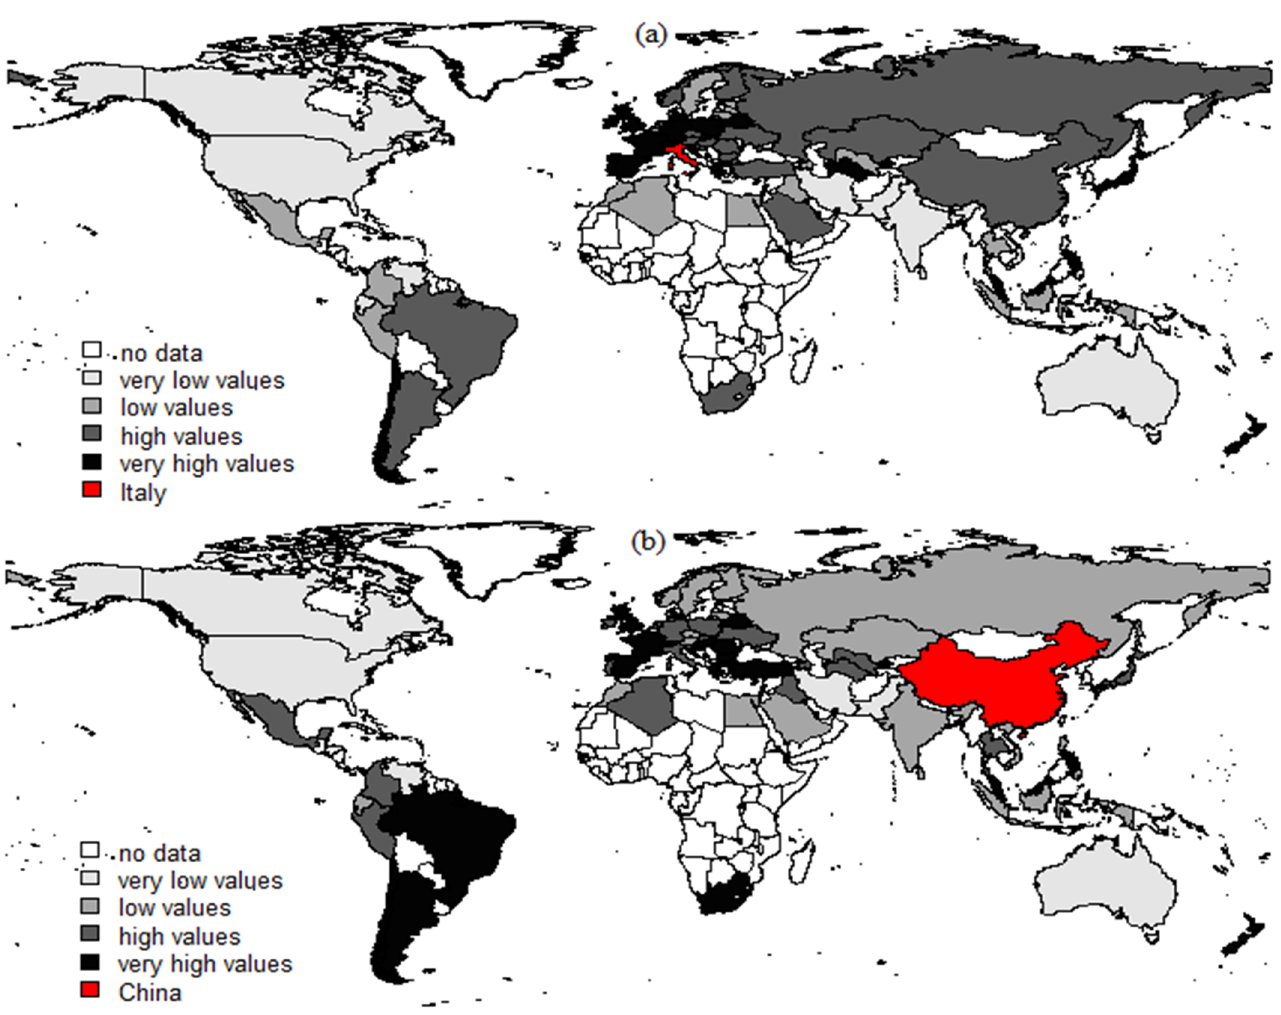
Figure 7. Dependence of CO 2 emissions of all other countries on the share of energy from renewable sources out of the total energy consumption in ( a ) Italy and ( b ) China.